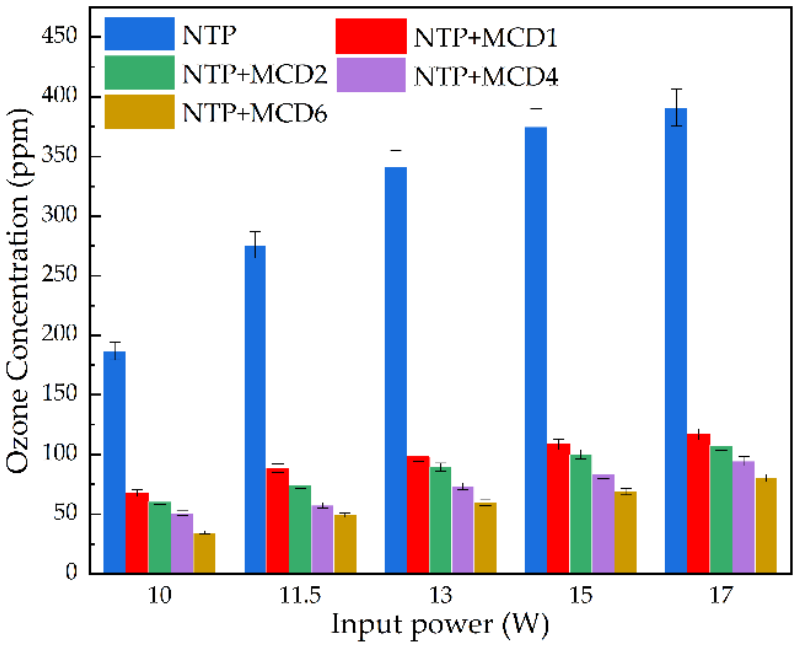
Figure 8. The effect of different catalysts on the O 3 concentration in NTP-MCDx system.